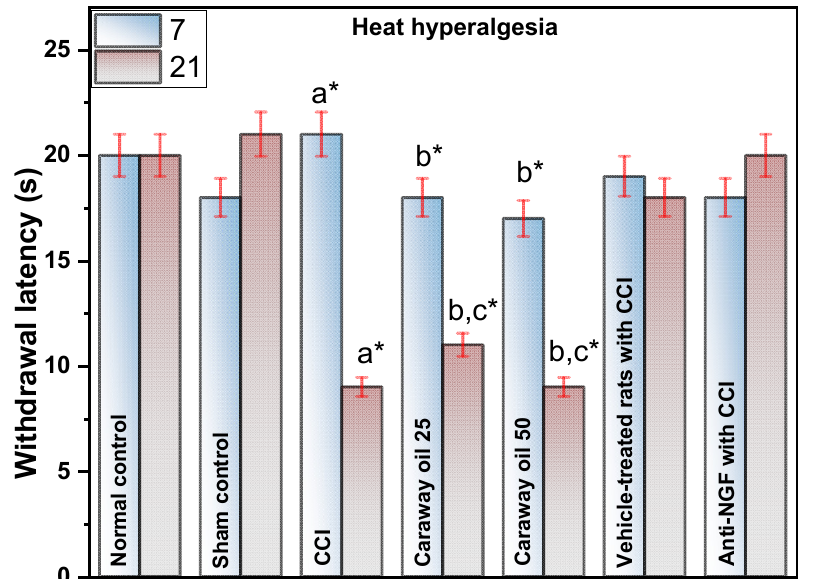
Figure 4. Effect of Caraway oil on CCI-induced heat hyperalgesia assessed by Eddy’s hot plate test. It is represented as mean ± SEM; n = 6. a p ≤ 0.05 against sham control correspondent to same day. b p ≤ 0.05 against CCI comparable to same day. c p ≤ 0.05 versus caraway oil and anti-NGF in CCI compatible to same day. * represents p -value ≤ 0.05.